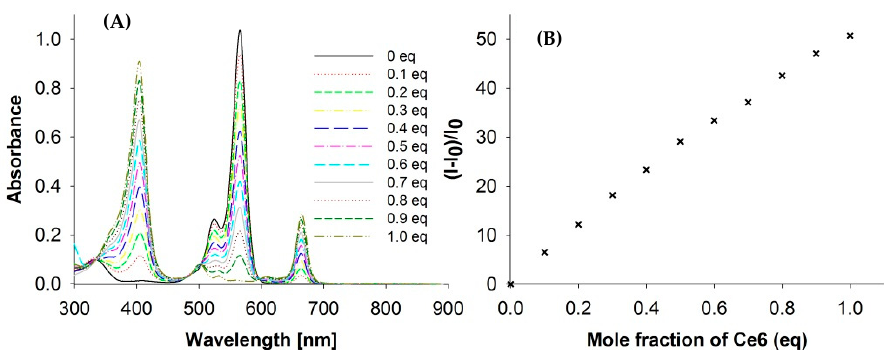
Figure 4. Job’s plot of RB vs. Ce6; ( A ) UV-Vis spectra during the addition of Ce6 equivalents to RB; ( B ) (I − I 0 )/I 0 vs. Ce6 eq during the addition of Ce6 equivalents to RB (concentration of the host—RB—2 × 10 − 5 )—Job’s plot.